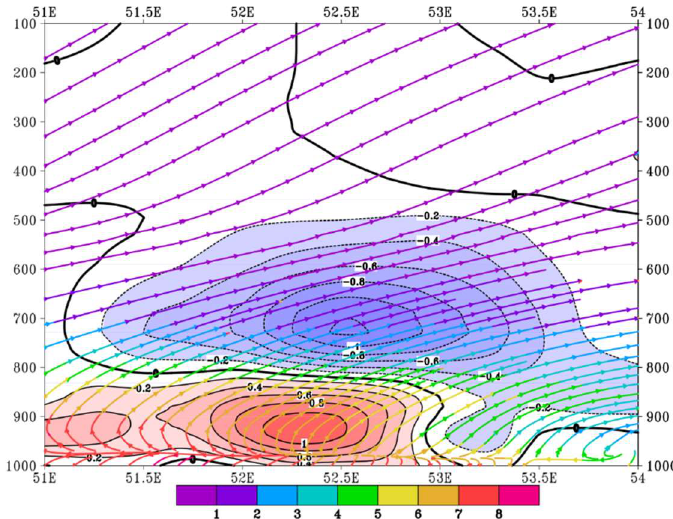
Figure 6. The vertical profiles of velocity (Pa s –1 ) (shaded) and moisture advection (10 −5 g Kg −1 s −1 ) (streamline) on 19 March for 00:00 UTC. Solid bold black lines indicate the vertical velocity having 0 value, solid black lines indicate the vertical velocity with positive values, and the black dashed lines indicate the vertical velocity with negative values. The scale bar indicates the specific humidity value (g/kg).